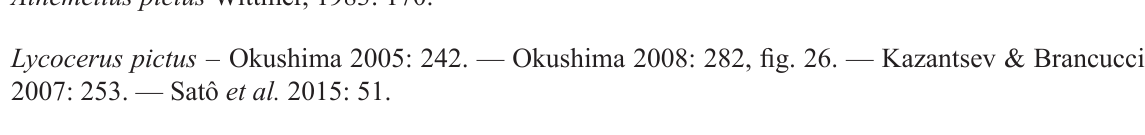
Eyes black. Head dark yellow, with black marking on vertex. Antennae dark yellow or black, with first two or three segments and basal parts of remaining segments dark yellow. Pronotum dark yellow, with black marking in medio-longitudinal part. Elytra completely pale yellow or slightly dark in narrow suture. Legs dark yellow, with apical parts of femora, tibiae and tarsi blackish. Prosternum dark yellow, mesoventrites, metaventrites and abdomen black, with margin of abdominal ventrites and entire abdominal ventrite VII yellowish brown. Body closely covered with fine yellowish pubescence; anterior margin of clypeus fringed with pale bristles; antennae, elytra and legs with some yellowish bristles intermingled with primary